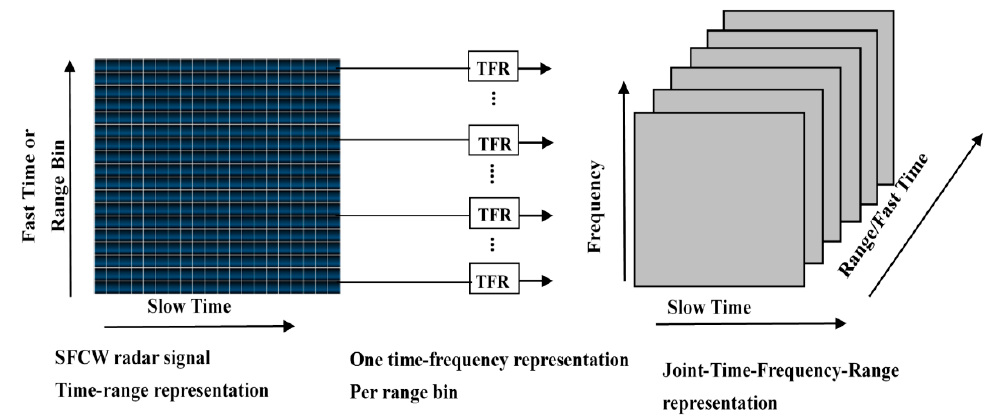
Figure 3. The joint time-frequency-range representation of the UWB radar signal.